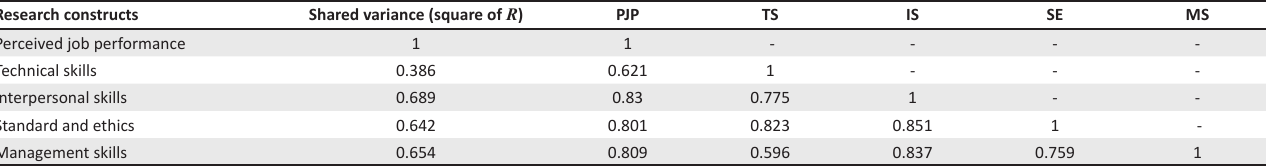
TABLE 4: Inter-construct correlations. Research